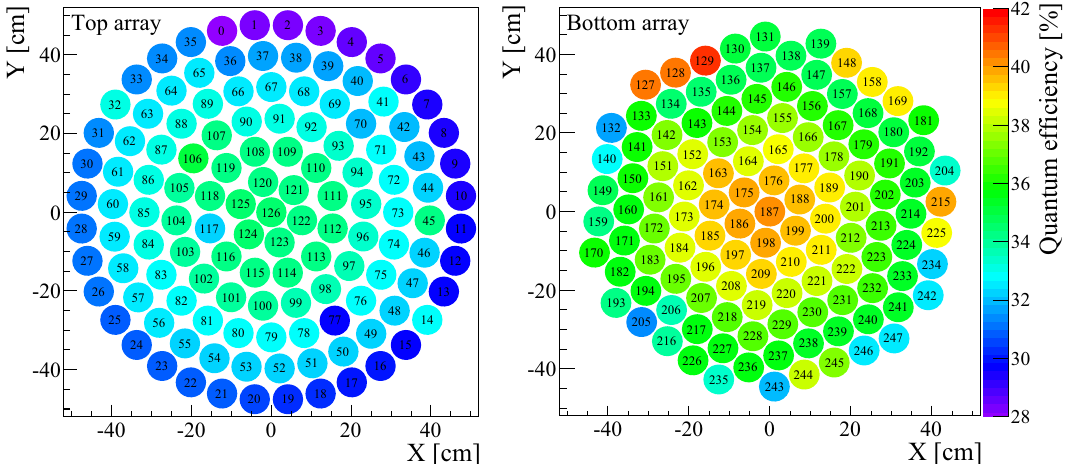
Fig. 5 The PMTs were distributed in the top and bottom arrays mainly according to theirquantum efficiency to ensure that the best-performing PMTs are located at the center of the bottom array, where most of the